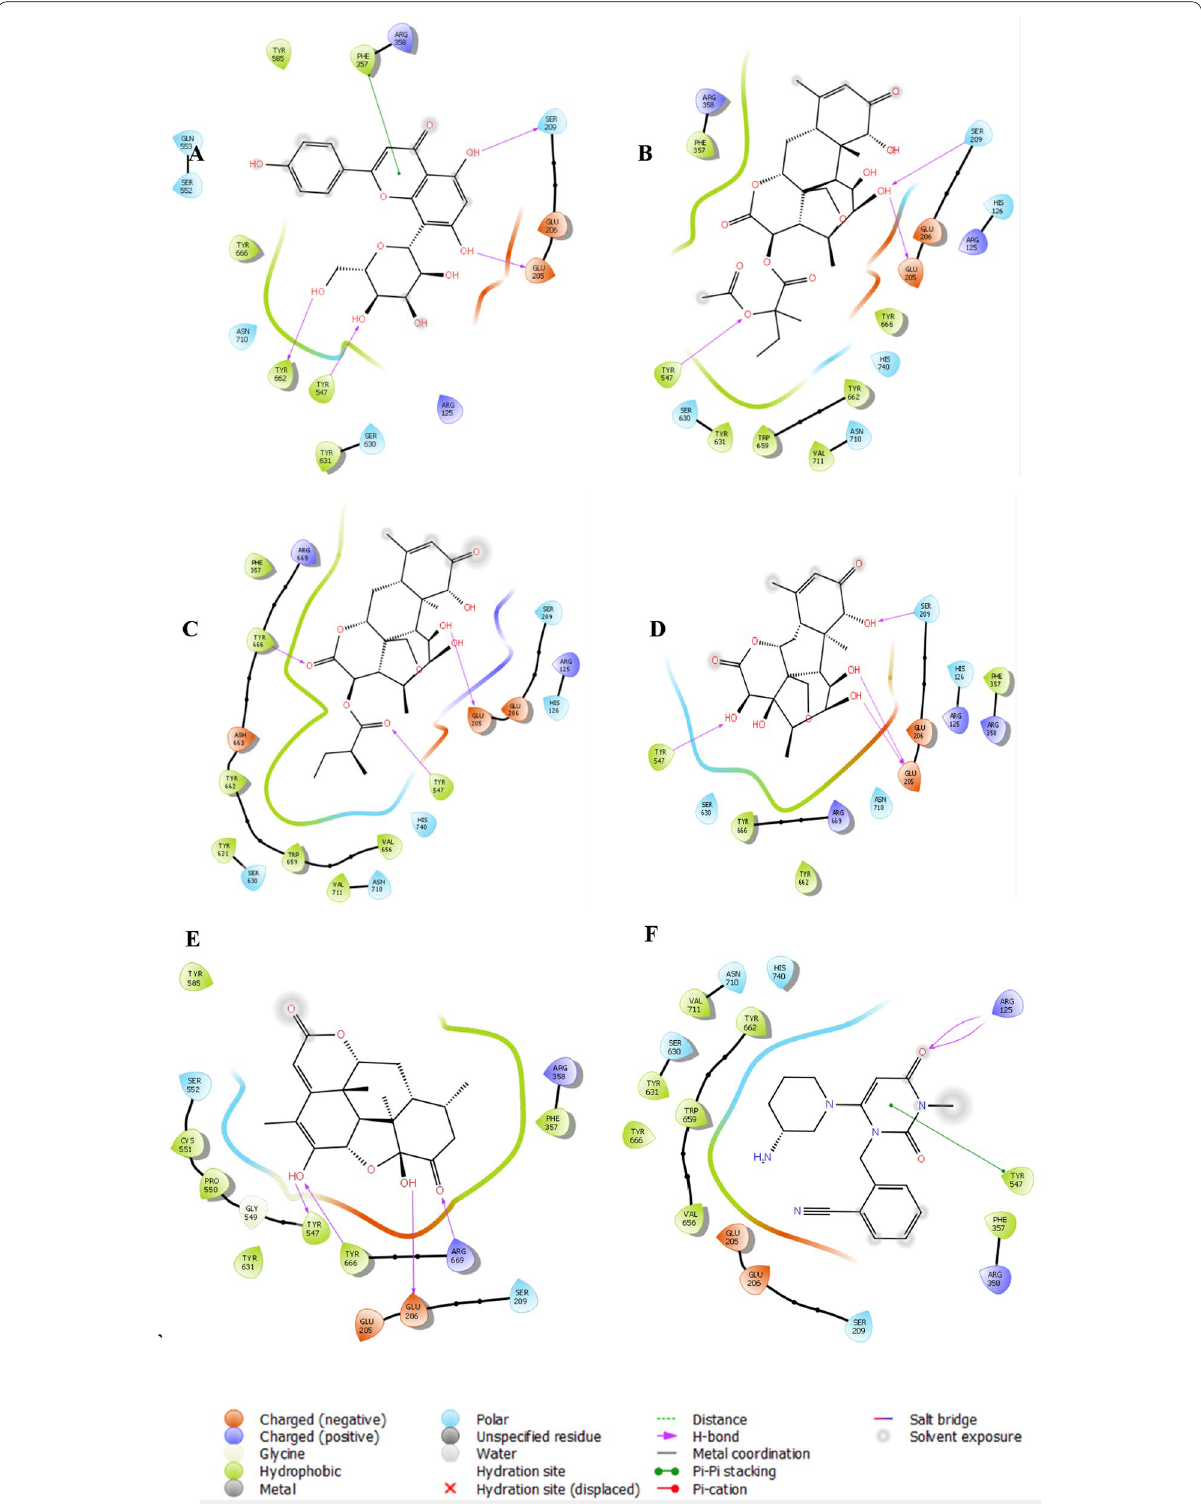
Fig. 3 2D-Molecular interactions of amino-acid residues of alpha-amylase with Quassia amara phytochemical constituents. A Vitexin, B Quassimarin, C Simalikalactone D, D Brucein D, E Quassinol and F